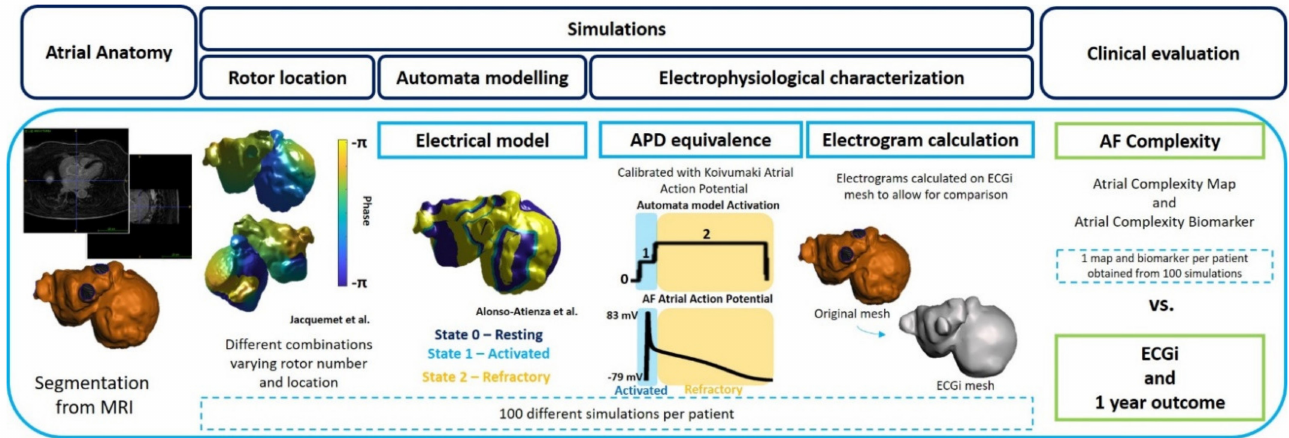
Figure 1. Simulation protocol (from left to right): Biatrial anatomy segmentation from MRI. Rotor location with Jacquemet algorithm on atrial anatomy. Simulation with 3-state protocol (Alonso Atienza et al. model) with rotor location obtained from Jacquemet et al. protocol. Electrophysiological characterization by translation of the activation pattern into APD equivalence and later electrogram calculation. Evaluation of the simulation by means of new biomarker calculation and validation with rotor